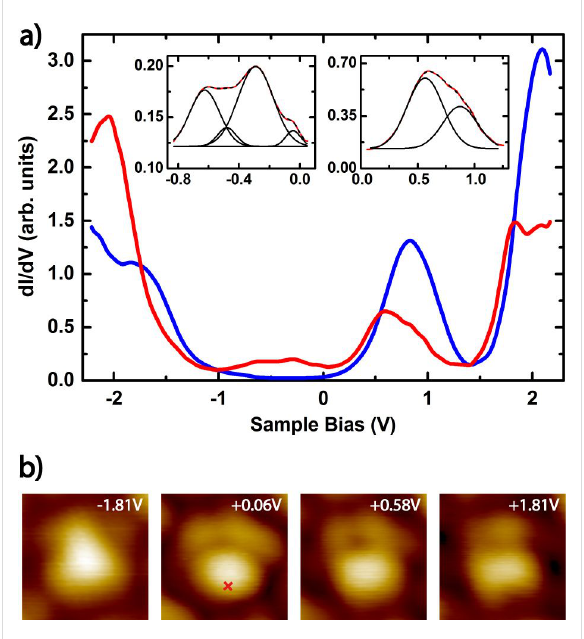
Figure 6: (a) Differential conductance spectra ( dI / dV ) over a C 60 mole- cule as indicated by the red cross in Figure 6b (red curve: U bias = 0.45 V, I T = 0.16 nA, 20 mV, 724 Hz; blue curve: U bias = 0.46 V, I T = 0.20 nA, 50 mV, 213 Hz). Inset: Gauss-curves fitted at the LUMO and the interface states. (b) C 60 orbital structure within the u-R30° domain at different U bias as indicated in the picture ( I T = 0.06–0.17 nA) (1.05 × 1.05 nm 2